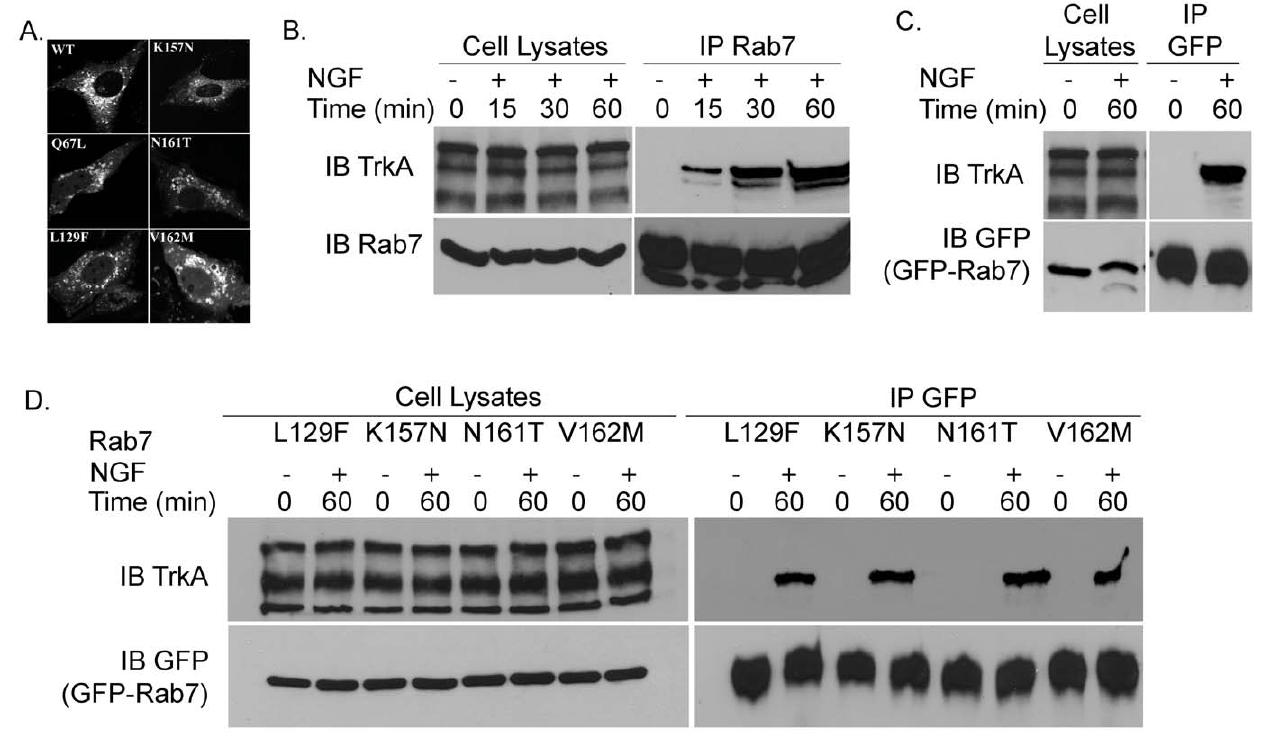
Figure 1. Rab7 CMT2B Mutants are Membrane Bound and Interact with TrkA. (A) BHK cells were transfected with GFP-tagged Rab7 wild- type and CMT2B disease mutants. After 16 h of transfection, cells were fixed and permeabilized by saponin treatment. Enlarged perinuclear vesicular staining was observed for the CMT2B disease mutants. (B) PC12 cells were stimulated with NGF (200 ng/ml) for 15–60 min as indicated. Cells were lysed and samples of cell lysates were immunoblotted for TrkA and Rab7. Lysate samples containing equal amounts of protein were immunoprecipitated (IP) with a pAb directed against Rab7 and immunoblotted for TrkA. Subsequently, the membrane was stripped and reprobed for Rab7. (C) PC12 cells were transfected with wild-type GFP-Rab7 and stimulated with NGF for 60 min. Samples containing equal amounts of protein were immunoprecipitated with antibodies against GFP to isolate the GFP-Rab7 and subsequently immunoblotted for TrkA. The membrane was stripped and reprobed with antibodies against GFP. (D) PC12 cells were transfected with GFP-tagged Rab7 CMT2B disease mutants and stimulated with NGF for 60 min. Equal amounts of lysate samples were immunoprecipitated with antibodies against GFP to precipitate the GFP-Rab7 and subsequently immunoblotted for TrkA. The membrane was stripped and reprobed with antibodies against GFP. (B–D) Representative blots from one of three independent experiments are shown in each case.